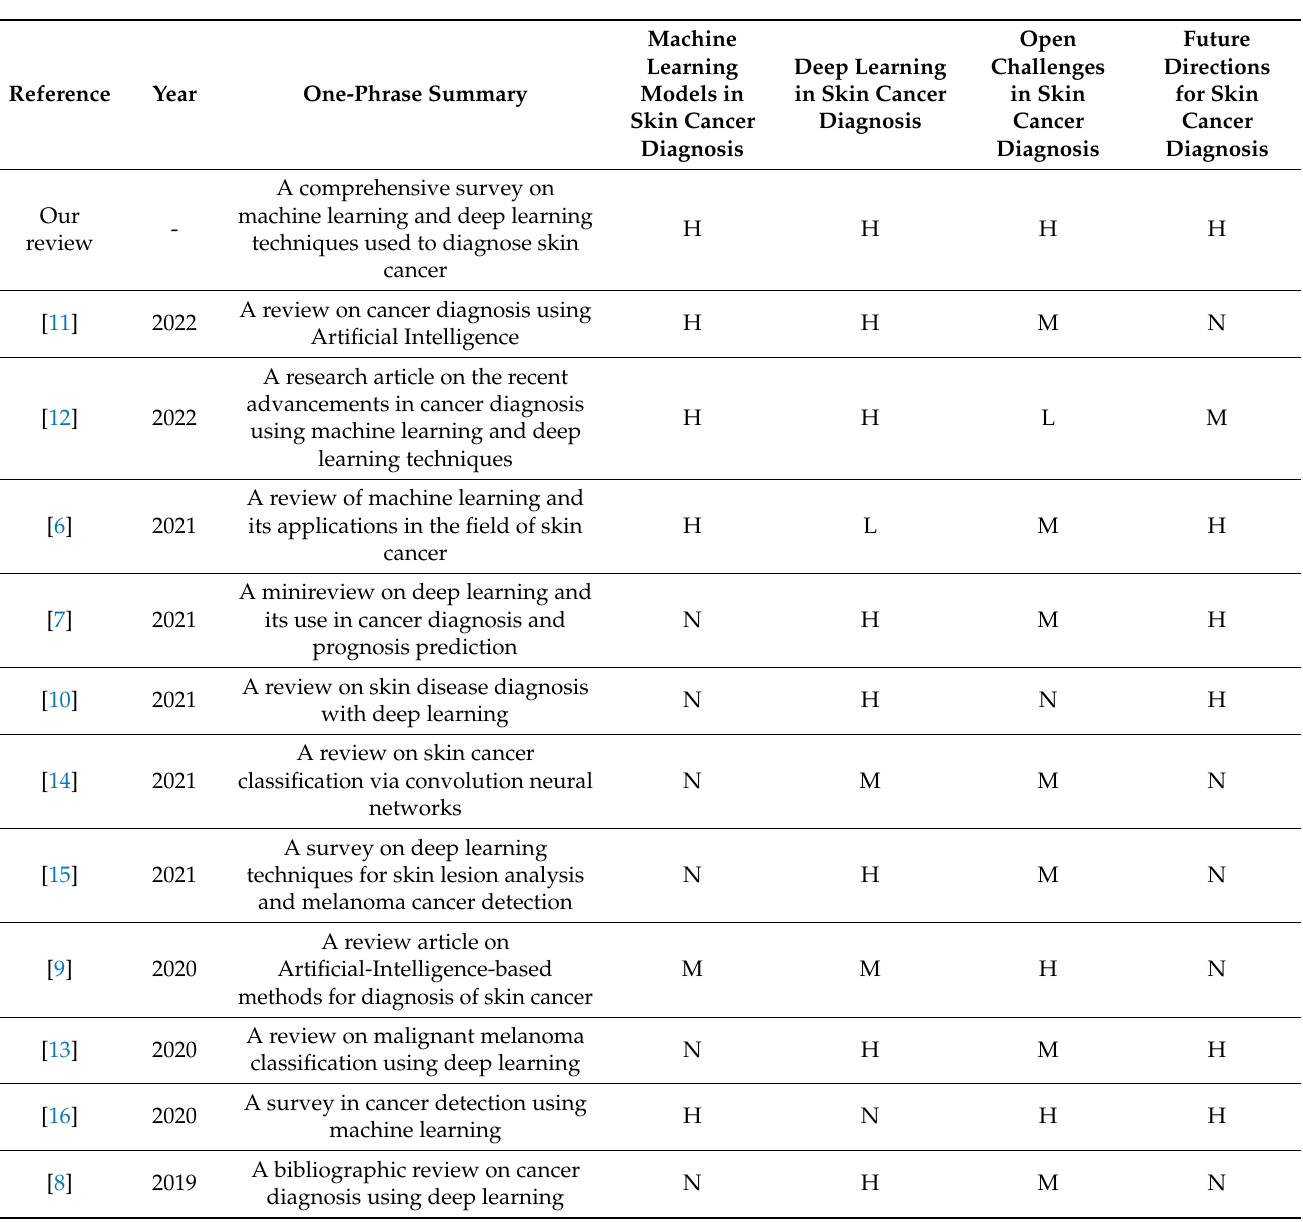
Table 1. Comparison of the current review with the previous reviews in AI-powered skin cancer